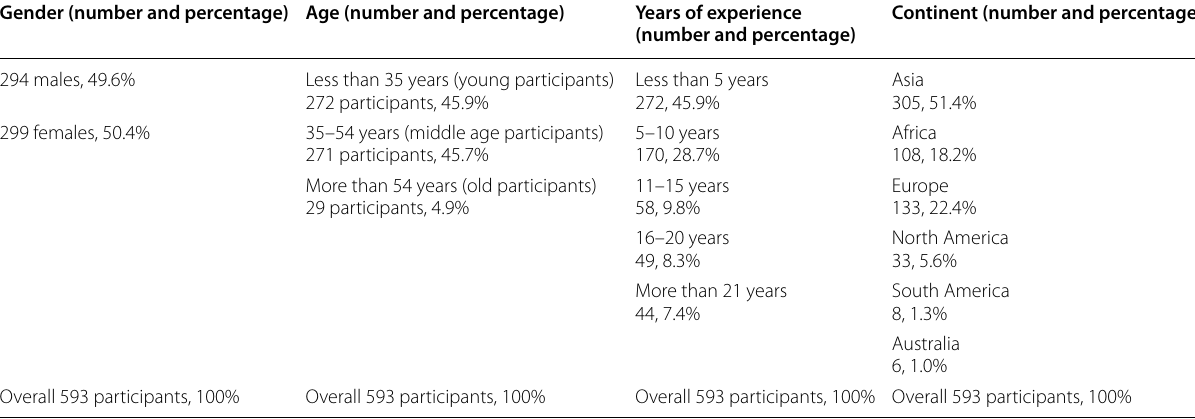
Continent (number and percentage) (number and percentage) Asia 305, 51.4%